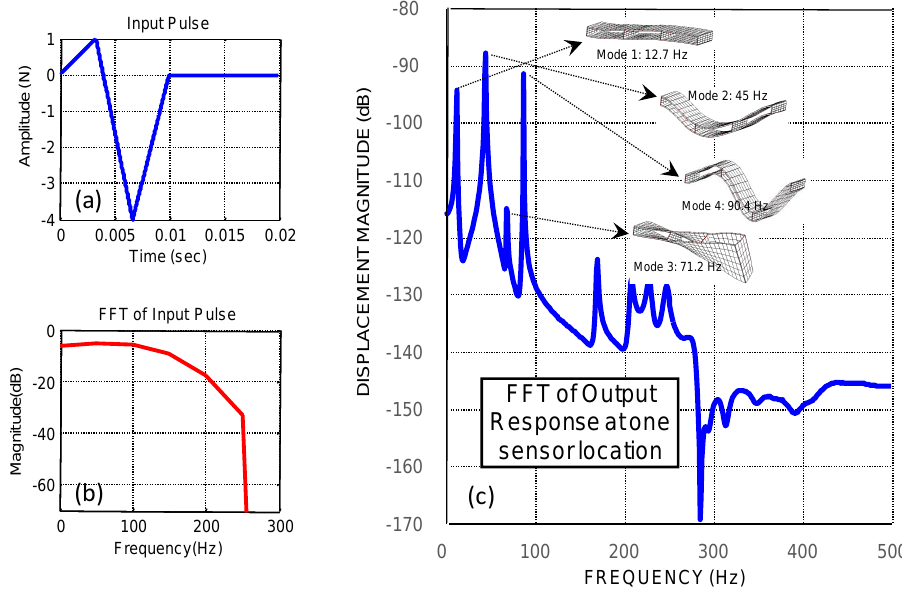
Fig. 4. Details of the excitation force and response of the